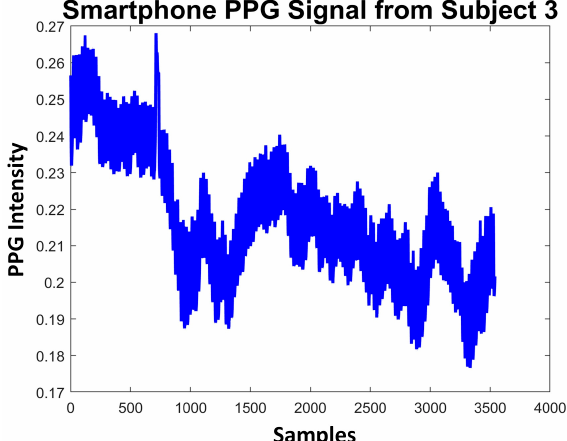
Figure 2. Raw smartphone signal from Subject 3.